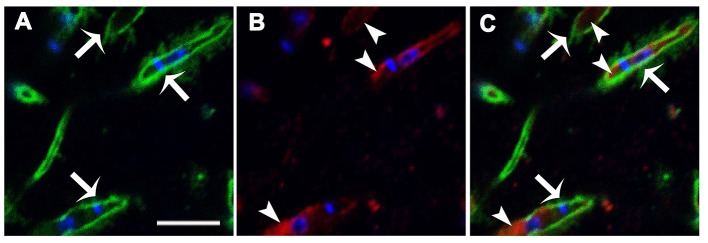
Immunolocalization of L. (V.) braziliensis (BA778) IPCs and GIPLs. Parasites were permeabilized with saponin 0.1%, fixed, labeled with mAb LST-1 (directed to Leishmania IPC; red), mAb SST-1 (directed to L. (V.) braziliensis glycolipids; green), and DAPI (nuclei and kinetoplasts; blue), and analyzed by confocal microscopy. (A–C) Representative optical section of focal plane showing intracellular labeling of IPC (arrowheads), and surface labeling of SST-1 (arrows). Scale bar: 5 μm.